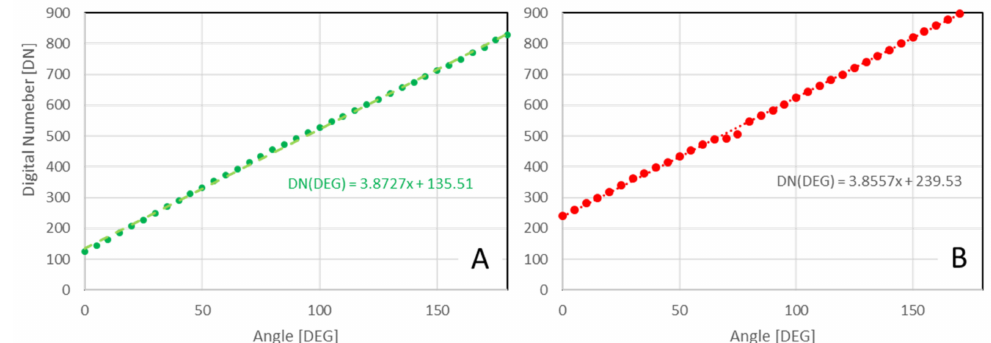
Figure 4. Potentiometer calibration of ( A ) azimuth potentiometer and ( B ) zenith potentiometer, made for angles between 0 and 180 [DEG] with 5 [DEG] step. The digital number (DN) is the voltage value read on the potentiometer’s pins and converted into a digital value by the Arduino Nano internal 12-bit resolution ADC (Analog to Digital Converter).